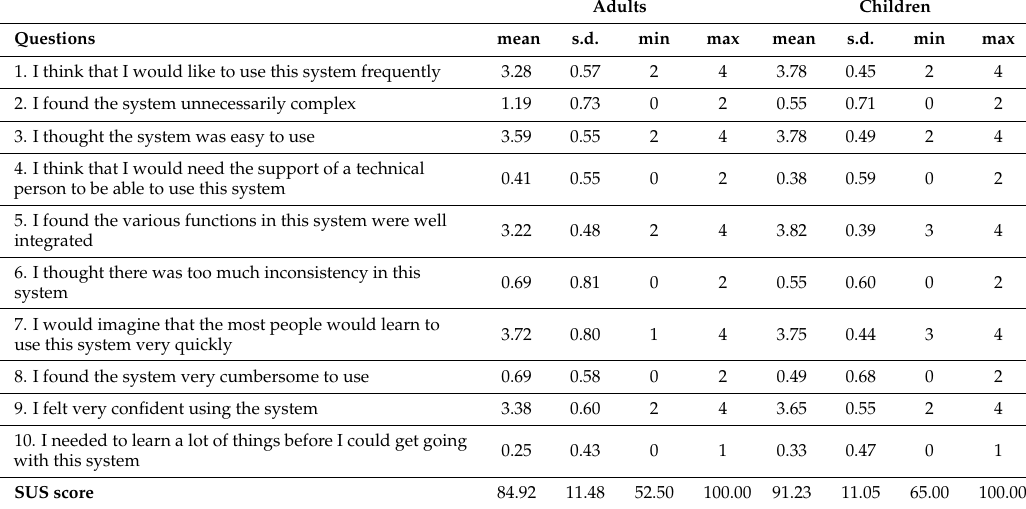
Table 4. Results of SUS questionnaire (mean, standard deviation, minimum and maximum).